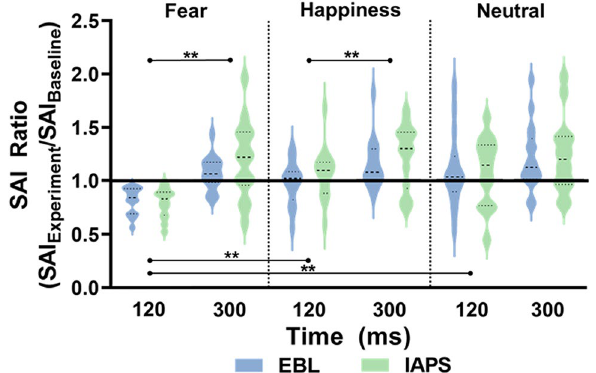
Figure 2. SAI Ratio data. The picture shows the violin plots of all SAI Ratio data for EBL and IAPS. A value greater than 1 (black thick line) indicates a decreased inhibition (SAI reduction) in relation to baseline, whereas a value lower than 1 indicates an augmented inhibition (SAI increase) in relation to SAI recorded at baseline. As observable, the only increase of SAI was at 120 ms after stimulus onset for fearful emotional stimuli. All SAI Ratio data computed at 300 ms showed a decreased SAI across emotional and neutral stimuli in both EBL and IAPS. SAI Ratio data are reported on the y-axis, while the two timepoints 120 and 300 ms are reported on the x-axis, separately for every condition. **p <